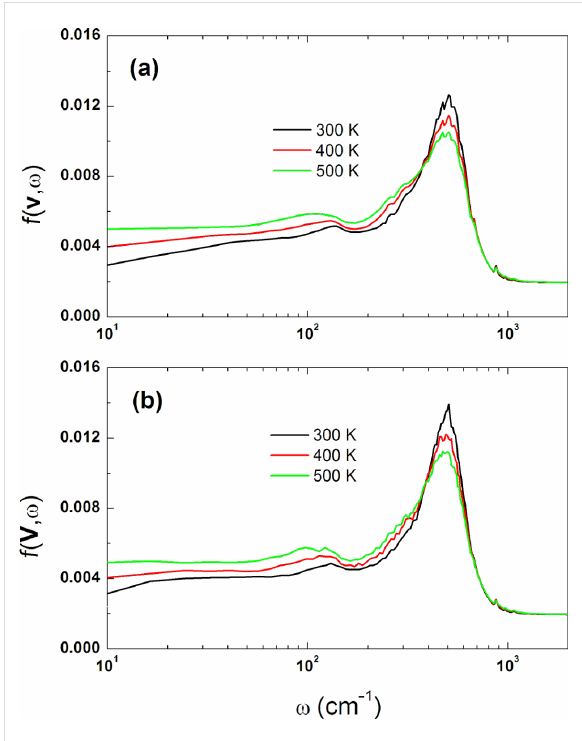
Figure 9: Spectral densities of (a) the hindered translational motions of individual cations and (b) the collective hindered translational motions of the cations calculated at a few temperatures indicated in the